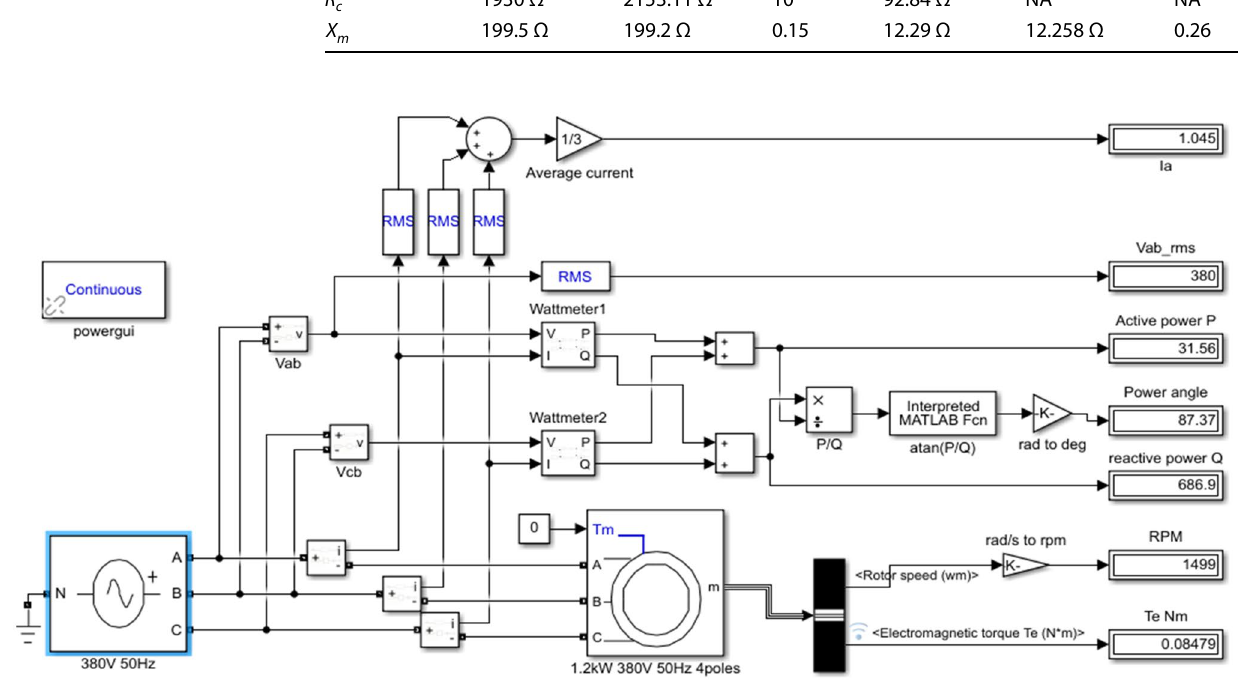
Fig. 3 Matlab Simulink model for three phase IM No-load test